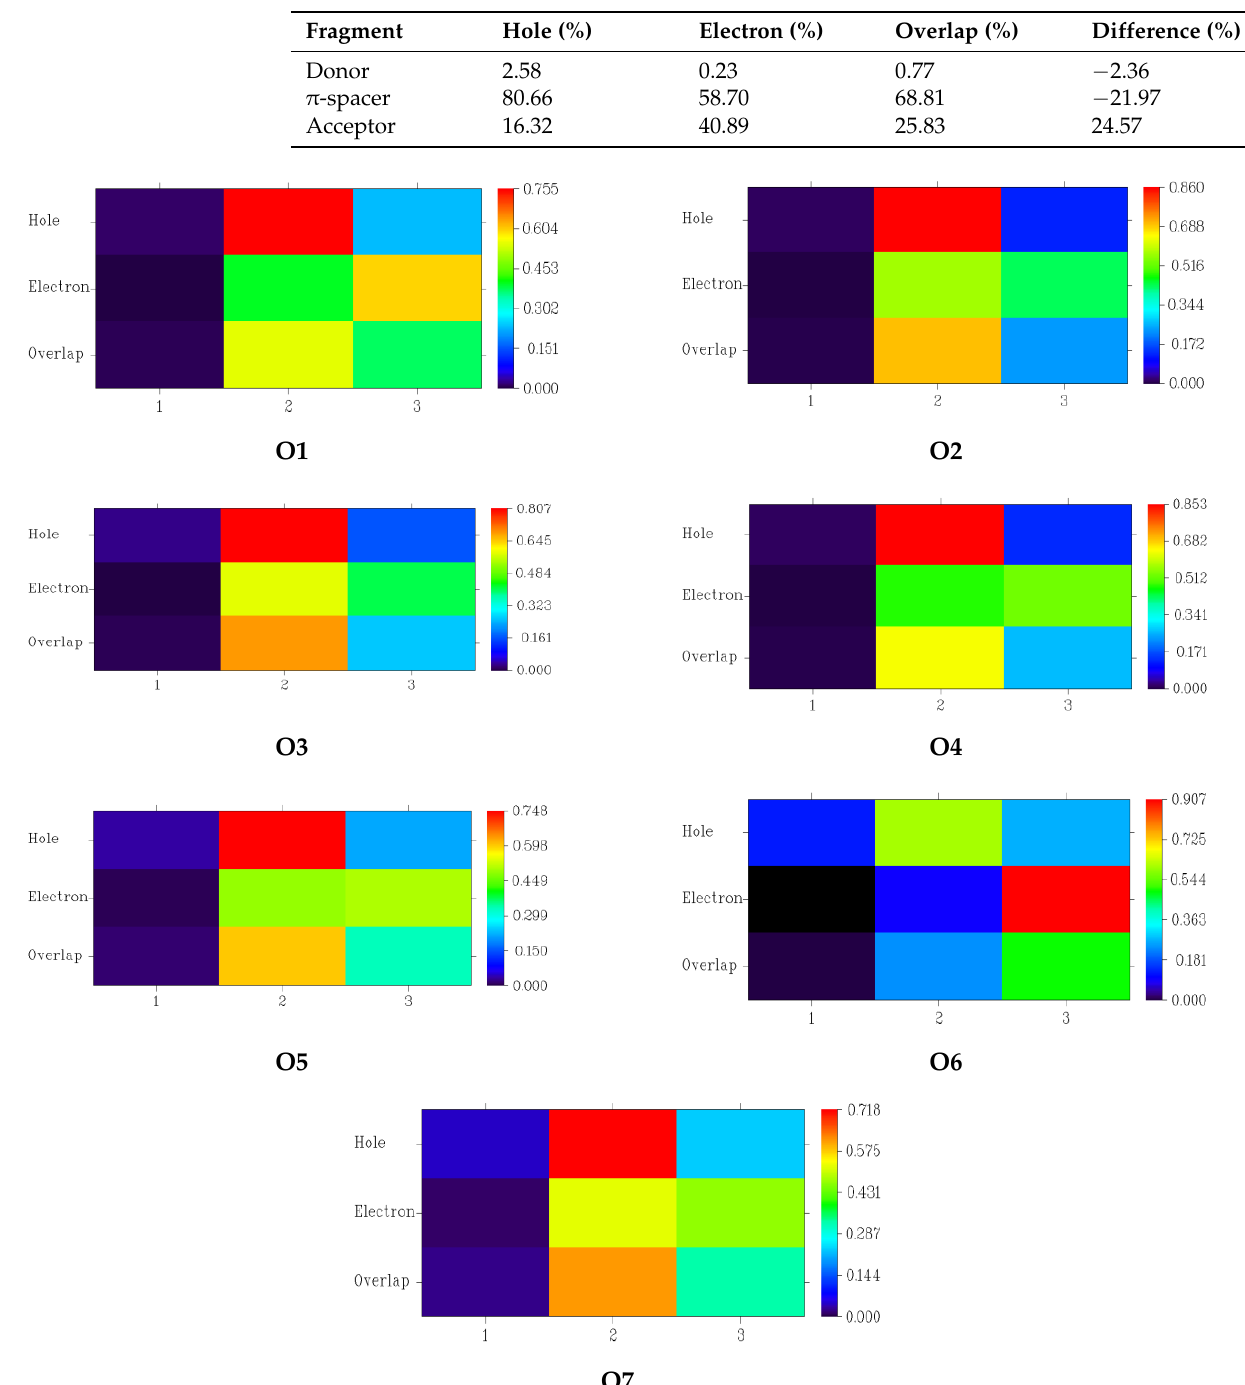
Figure 4. Electron–hole overlaps for each fragment within each